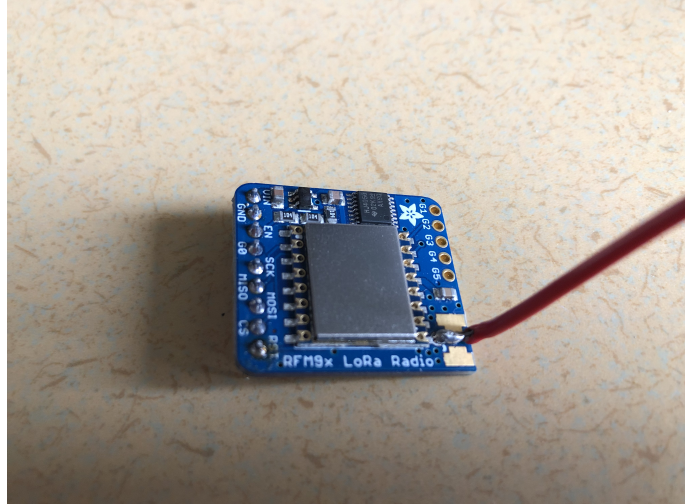
Figure 3. LoRa radio chip—Adafruit